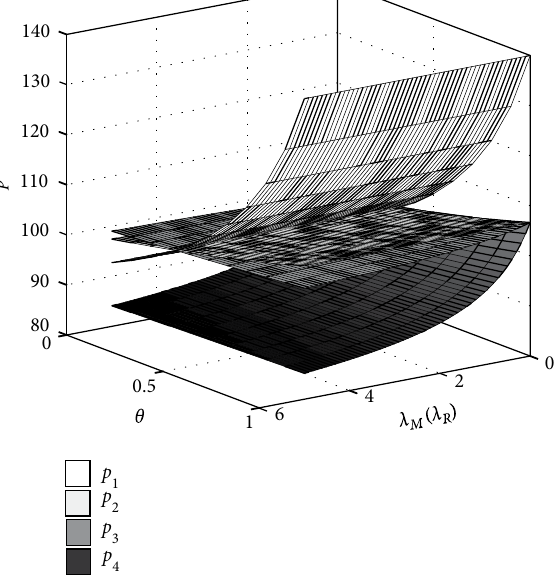
Figure 3: The effect of 𝜃 , 𝜆